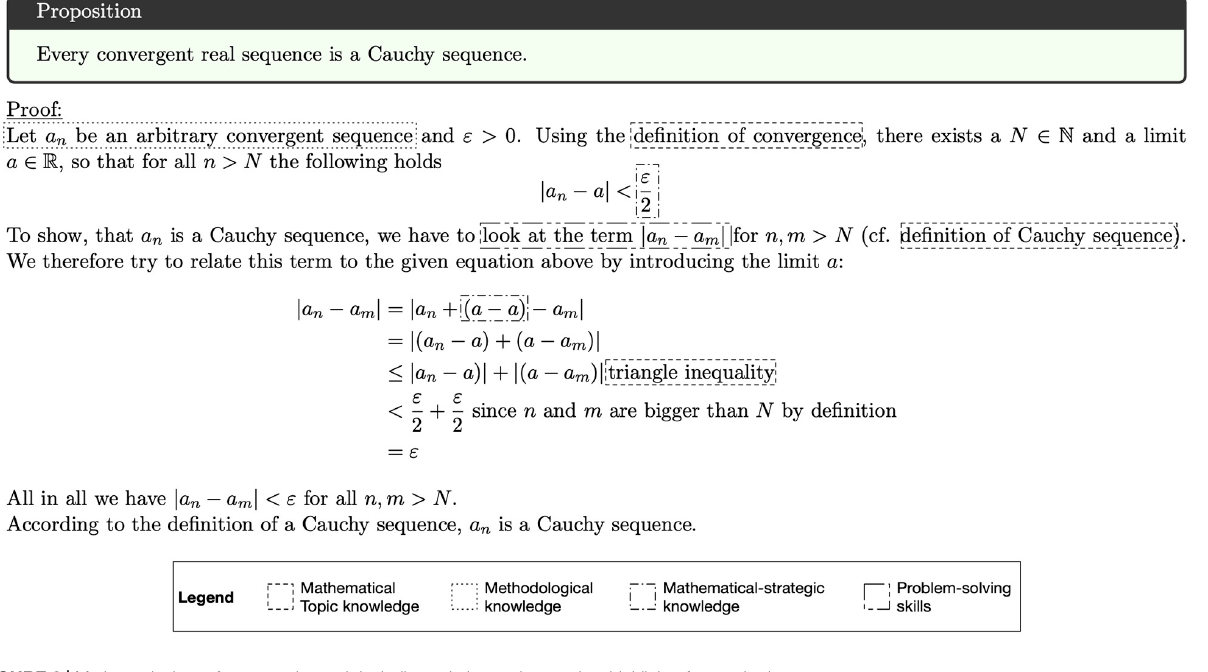
FIGURE 2 | Mathematical proof construction task including solution and exemplary highlights for required